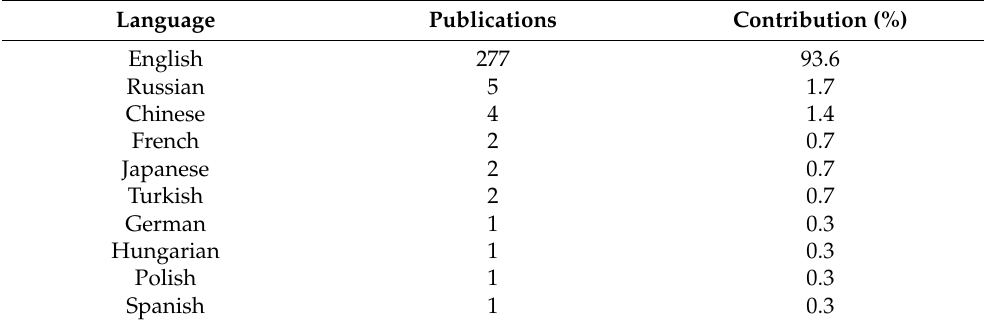
Table 1. The languages employed by the